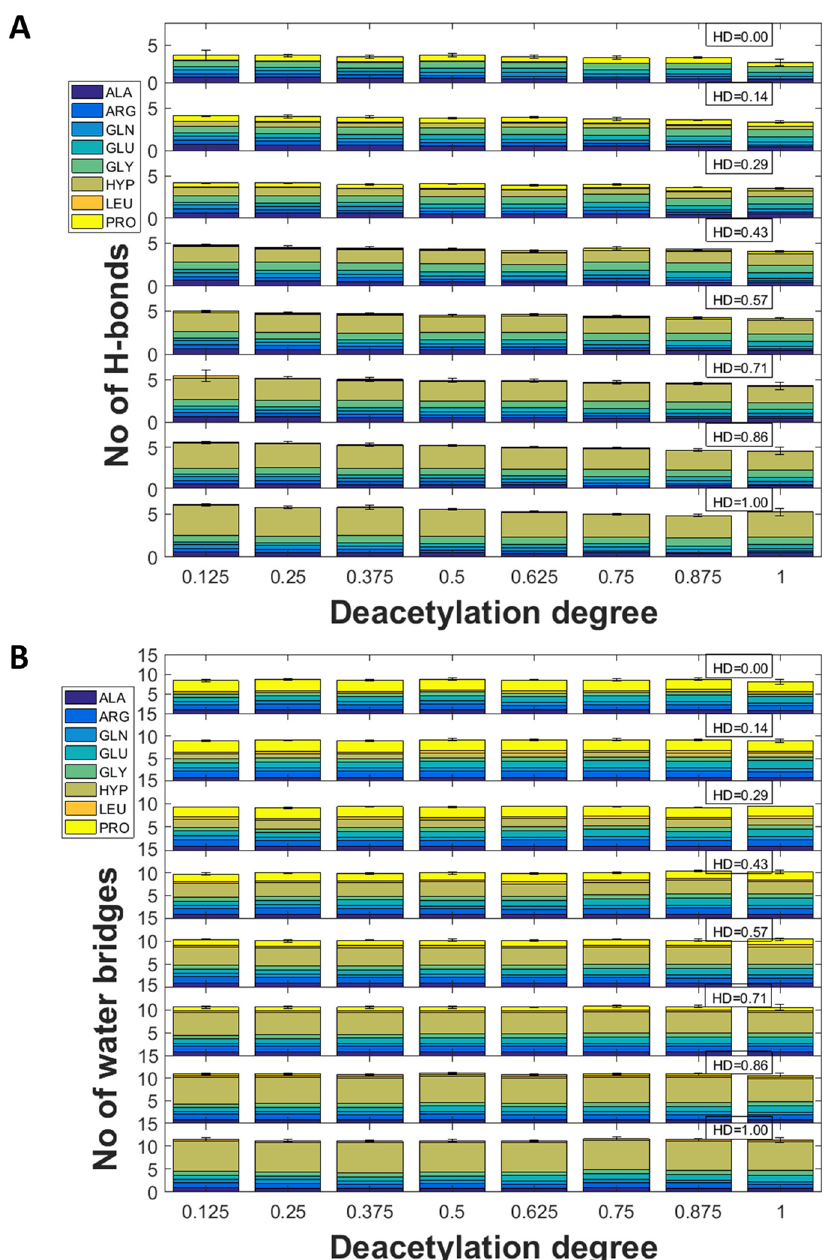
Figure 4. The distributions of direct ( A ) and indirect ( B ) hydrogen bonds identified in different collagen-chitosan complexes.